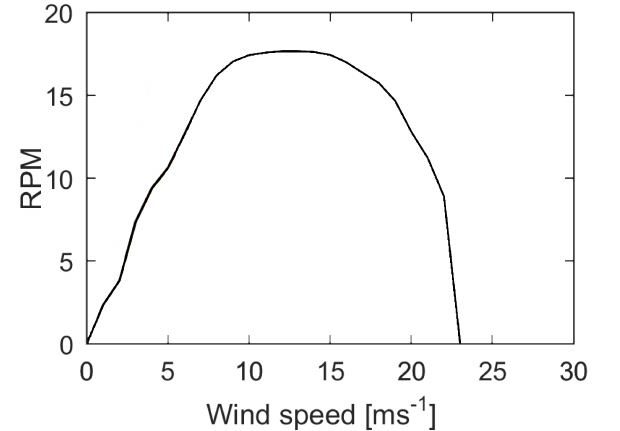
Figure 7. Wind turbine RPM curve adapted from [38]. The turbine rotates at an approximately rated speed over the wind speed range of 9 ms − 1 –16 ms − 1